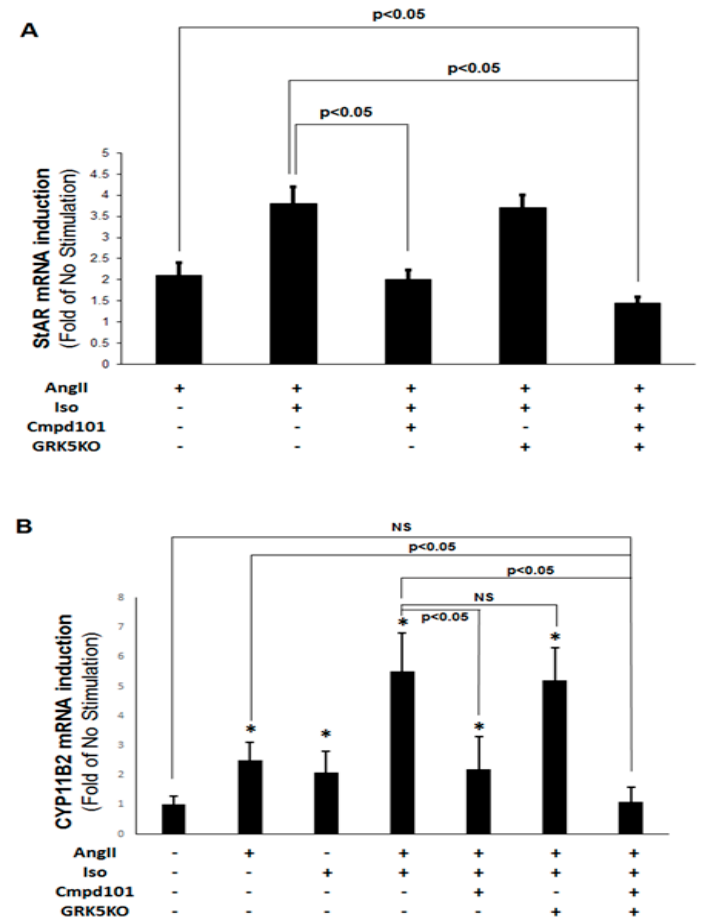
Figure 3. GRK2 mediates the β AR-induced enhancement of AngII-dependent aldosterone synthesis in AZG cells. H295R cells were treated for 2 h with 100 nM AngII alone or with 100 nM AngII and 10 µ M isoproterenol (Iso) combined, in the presence of 30 µ M Cmpd101 or after transfection with a CRIPSR lentivirus to knockout GRK5 (GRK5KO) or both (Cmpd101 + GRK5KO). At the end of the 2-h-long treatment, cells were harvested and total RNA was isolated to perform real-time PCR for StAR ( A ) or CYP11B2 ( B ) mRNA levels quantitation. Results were normalized based on the mRNA levels of the housekeeping gene 18S and are expressed as fold of control (no stimulation). ( A ) n = 5 independent experiments / group; ( B ) *, p < 0.05, vs. Control (No stimulation); NS: Not significant at p = 0.05; n = 5 independent experiments/group.